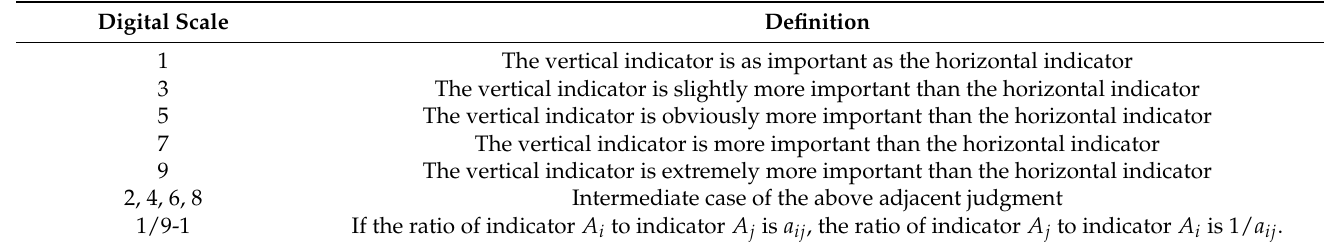
Table A6. Competency assessment indicators’ relative importance assessment rules.